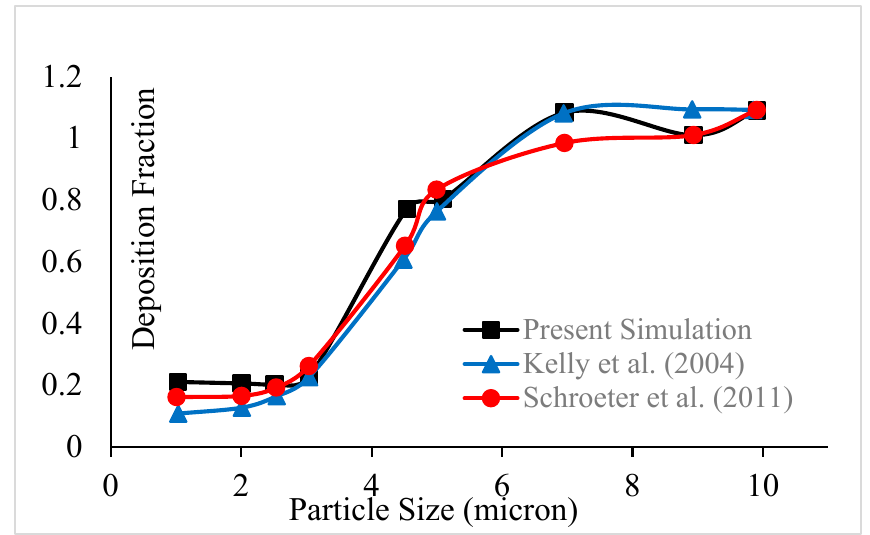
Figure 3. Validation of deposition efficiency of RSPM in the nasal cavity at 30 L/min [61,62].